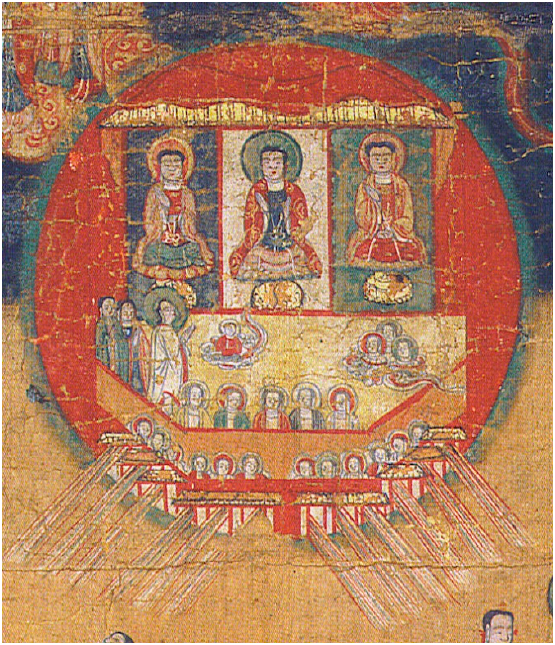
Figure 13. The Sun in the Liberation Light (Yoshida and Furukawa 2015, Plate 5).